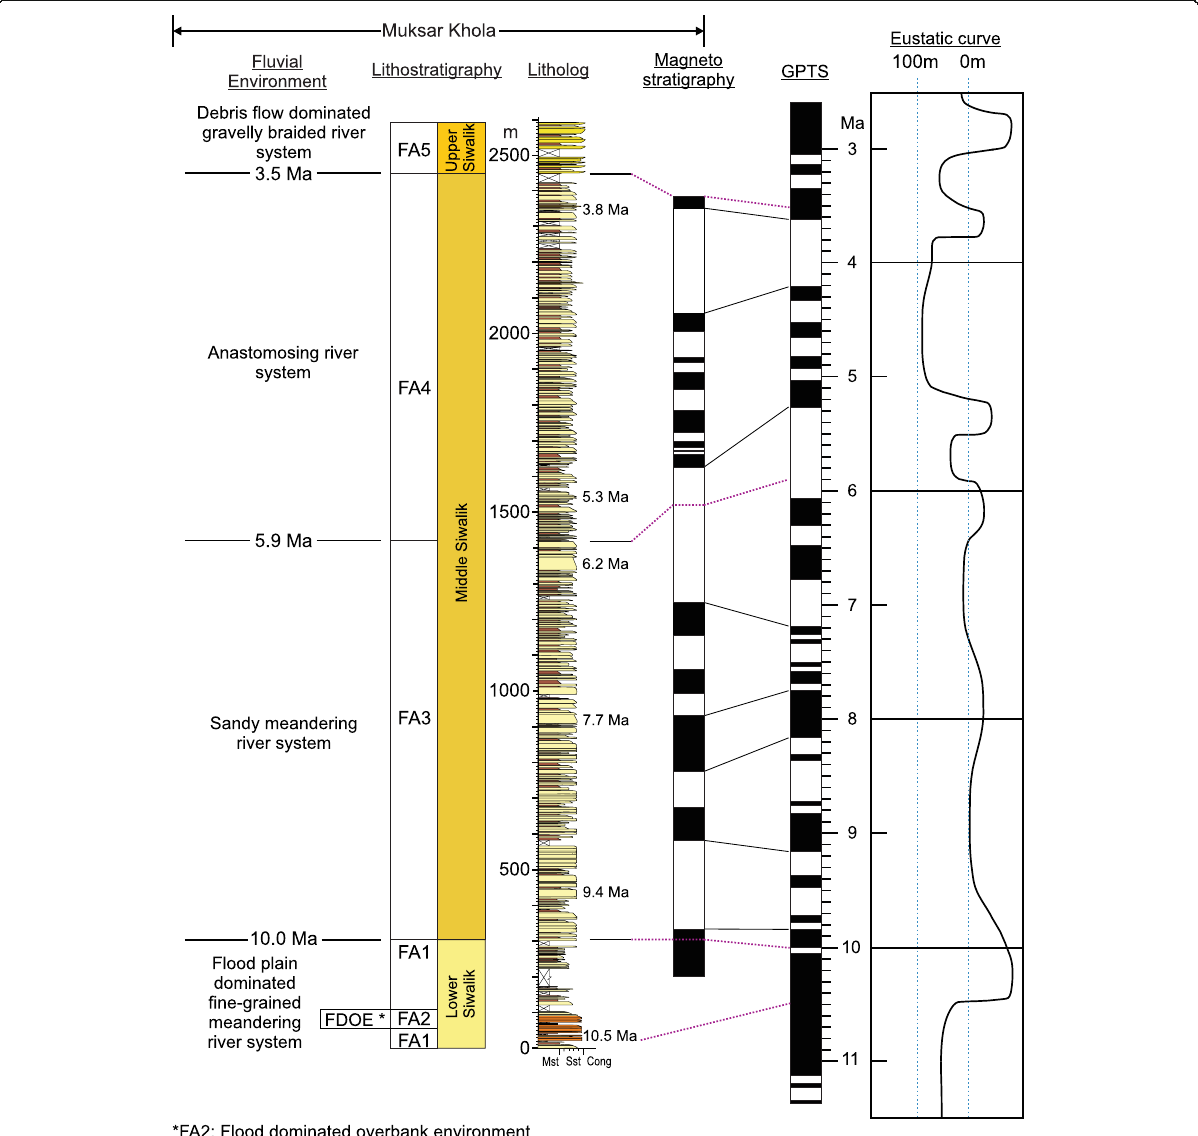
Fig. 5 Evolution of the fluvial style in the present study area based on a magnetostratigraphic time frame (modified from Ojha et al. 2009), GPTS (modified from Lourens et al. 2004) and the eustatic curve (modified from Haq et al.